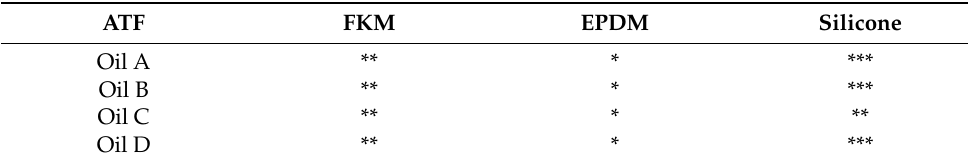
Table 10. Oil compatibility with the studied elastomers. ATF